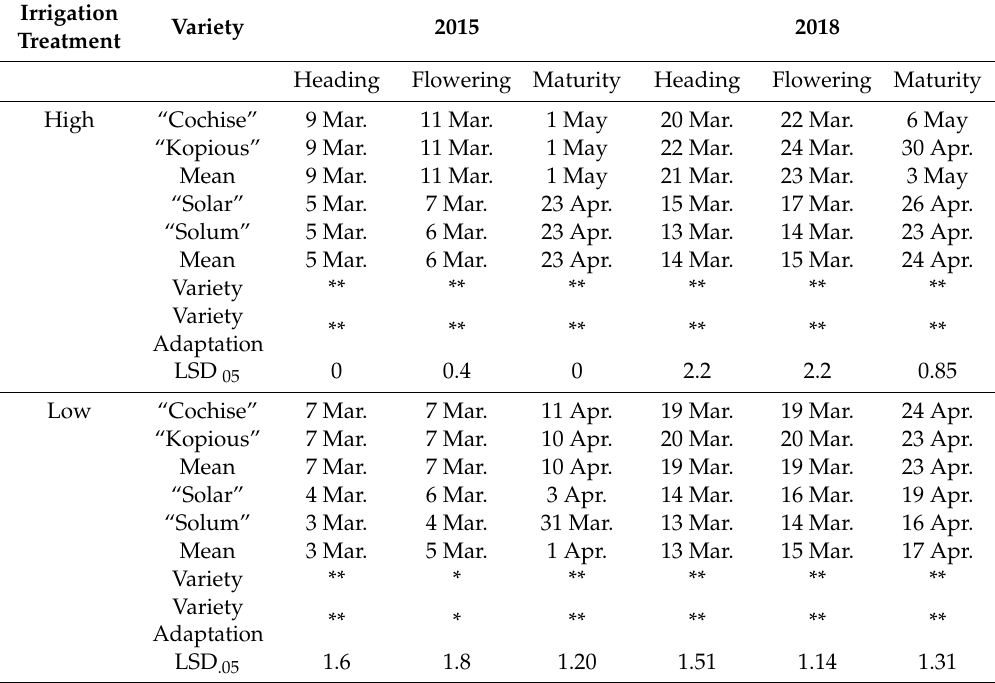
Table 5. E ff ect of irrigation treatment on heading, flowering and physiological maturity of barley by date for trials conducted in Tucson in 2015 and 2018. Irrigation Treatment